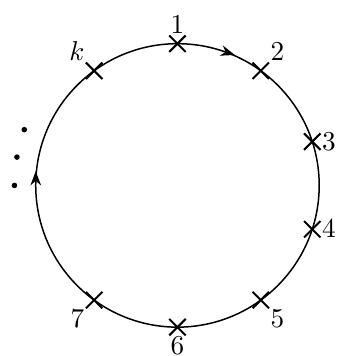
Figure 1 . To compute C k , draw a circle with k crosses labeled 1 to k . Each cross represents a E in equation